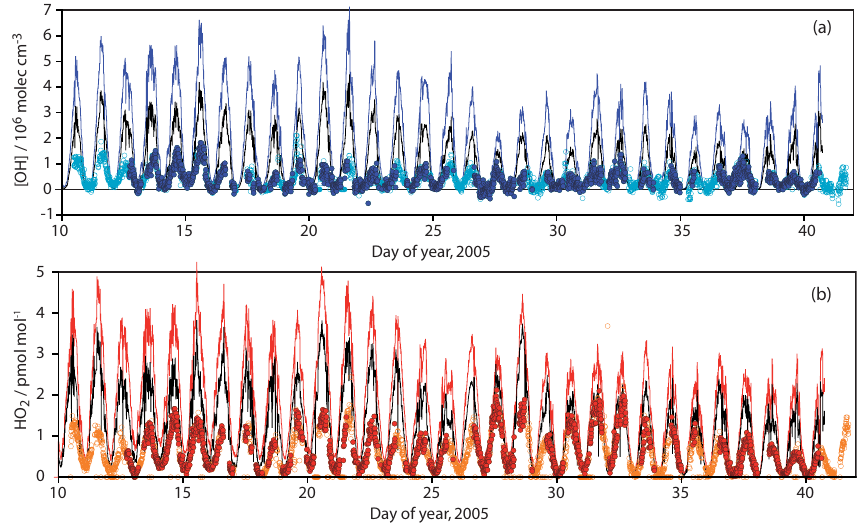
Fig. 2. Observed and simulated times series of (a) OH concentrations and (b) HO 2 mixing ratios. Open circles: all HO 2 observations. Filled circles: observations for which all other data present, as used in model-measurement comparisons. Blue line/red lines: model case A; black lines: model case